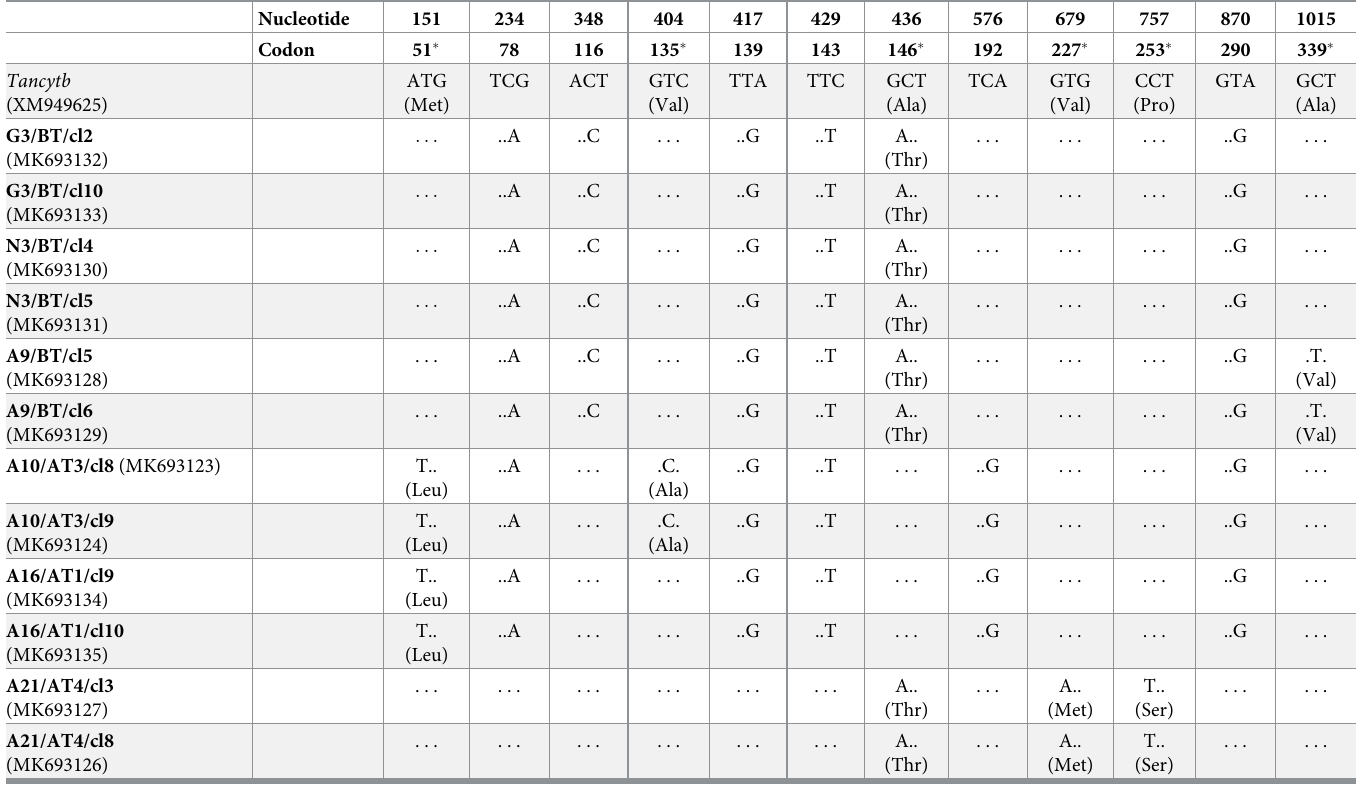
Table 3. Mutations detected in the Cyto b gene of Tancytb reference gene in PiroplasmDB database and different T . annulata isolates. Nucleotide